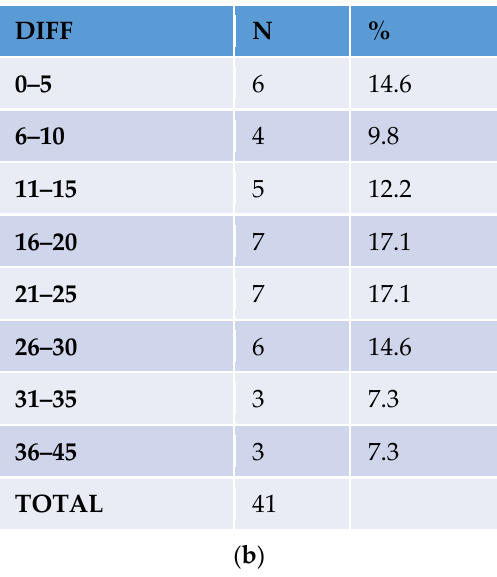
Figure 2. CGAS results after pharmacogenetic intervention: ( a ) final CGI scores; ( b ) CGAS score difference (CGAS final – basal).